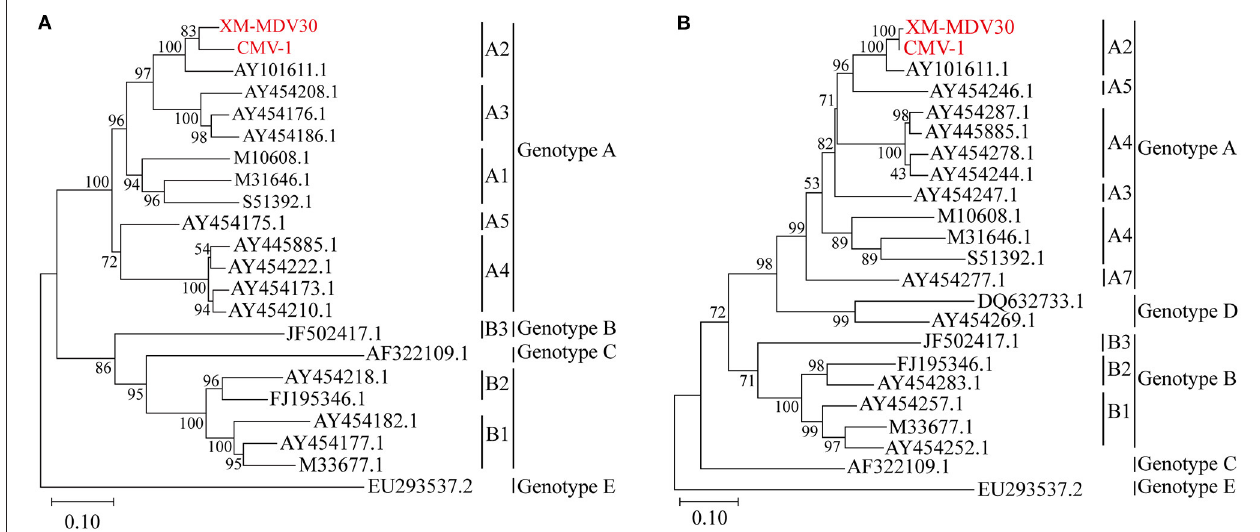
FIGURE 4 | Genotyping of Visna/Maedi virus isolates. The evolutionary history was inferred using the maximum likelihood method based on the Kimura 2-parameter model (37). (A) Maximum-likelihood tree based on a 684-bp fragment of the partial gag fragment with 1,000 bootstrap replicates. (B) Maximum likelihood tree based on 1,133 bp long fragment of the 1.2kb gag-pol fragment with 1,000 bootstrap replicates. The VMV genomes sequenced are marked in red. The scale bar indicates the number of nucleic acid changes per